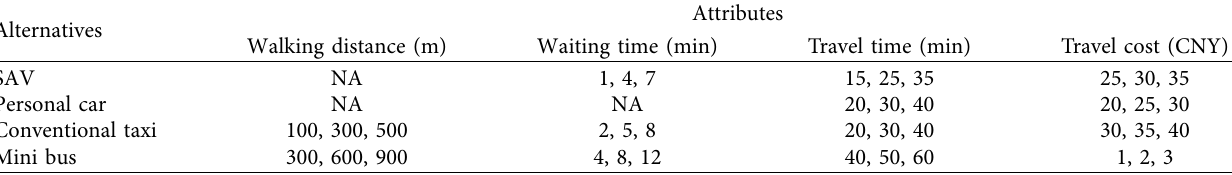
Table 4: Levels of the attributes for each of the alternatives in Dalian.